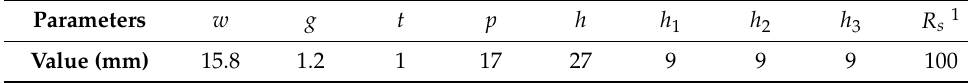
Figure 1. Geometry of the proposed MMA. ( a ) Perspective view of one unit cell. ( b ) Perspective view of one unit cell in the opposite direction. ( c ) Perspective view of absorber. Table 1. Parameters of the proposed absorber.